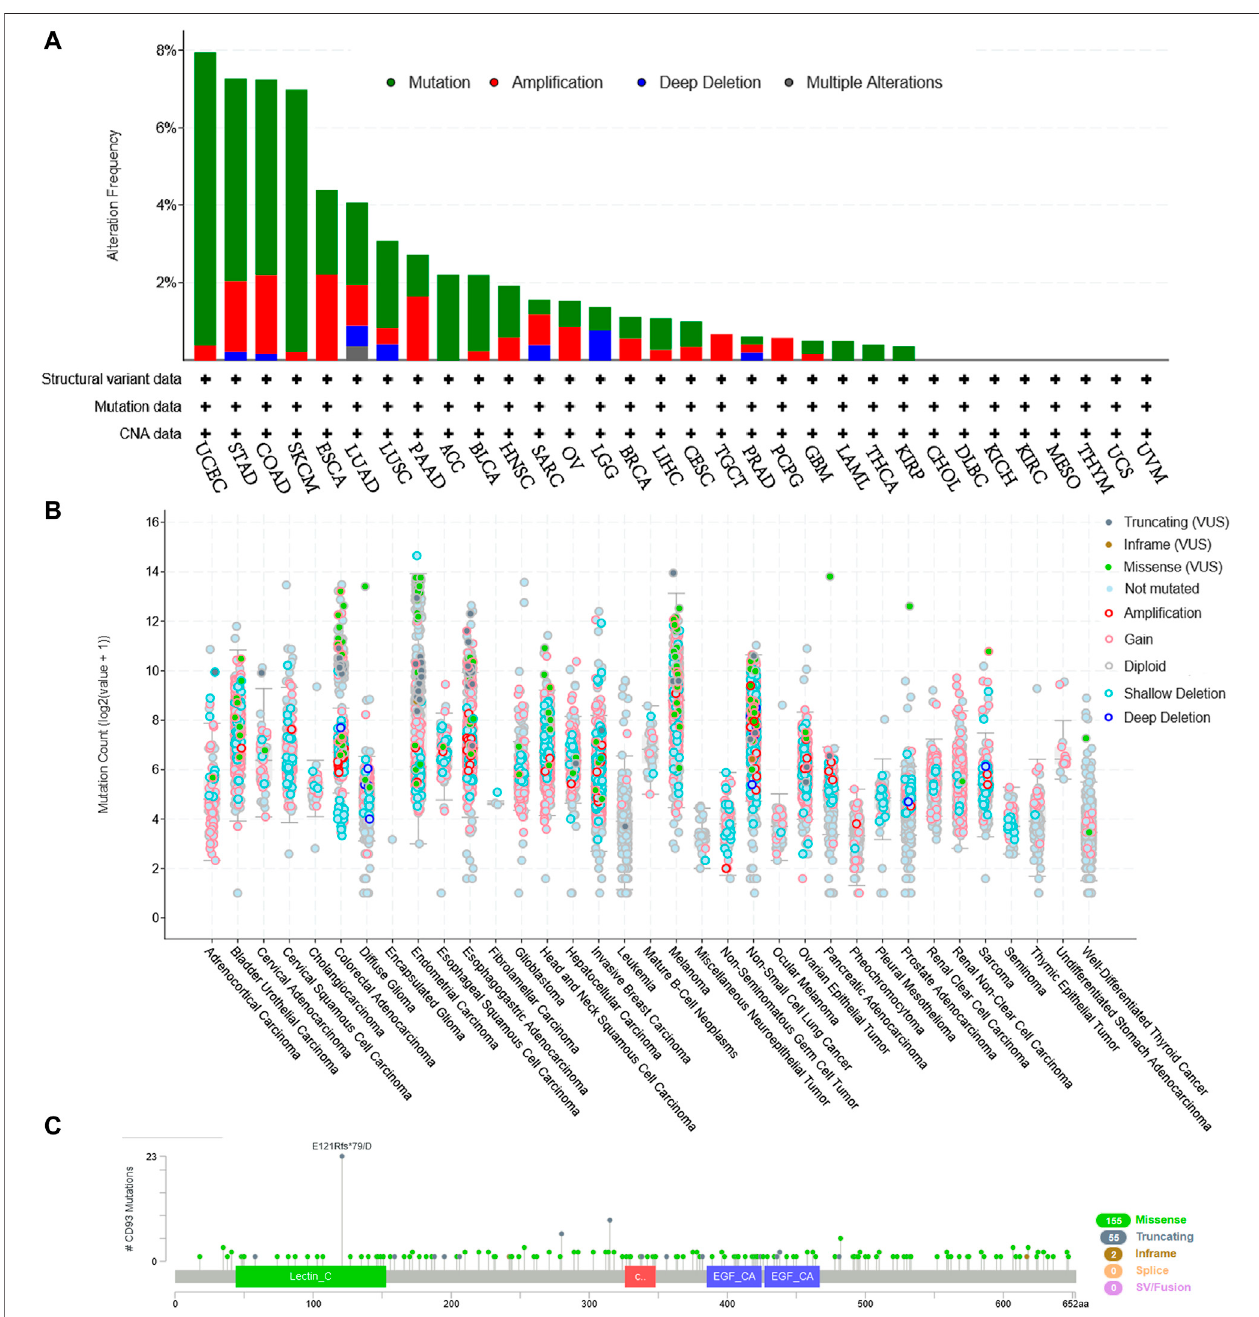
FIGURE 8 | CD93 mutation landscape according to the cBioPortal database. (A) CD93 mutation frequency in multiple cancer types in The Cancer Genome Atlas (TCGA). (B) Mutation counts across different cancers. (C) Mutation diagram of CD93 in different cancer types across protein domains.